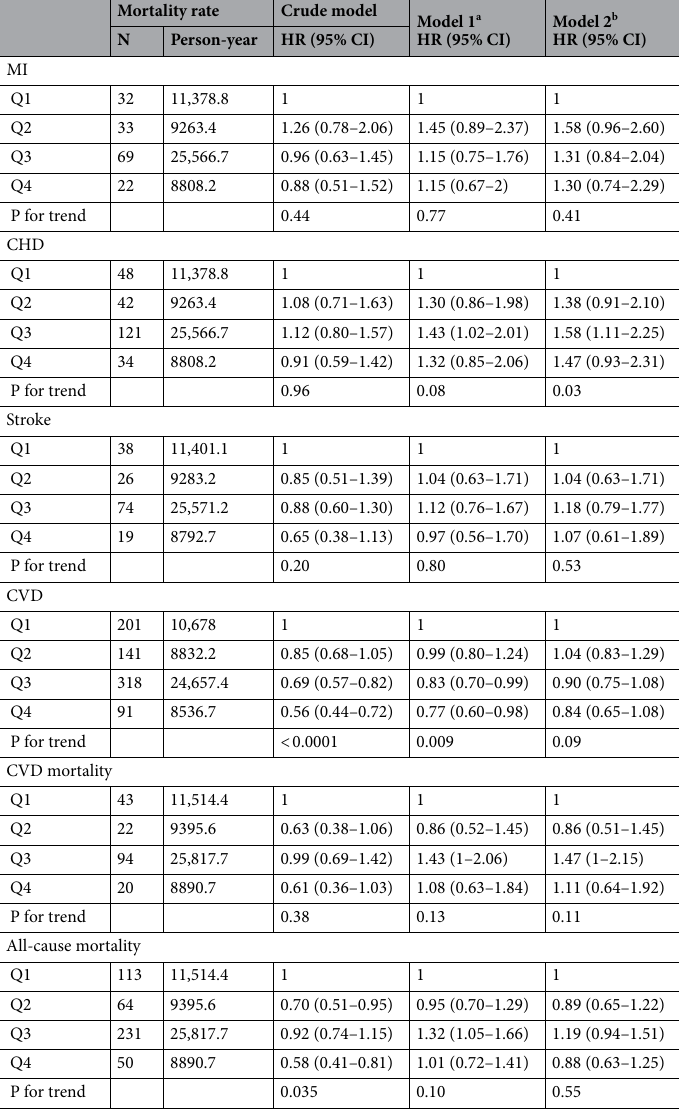
Table 7. Multiple adjusted relative risk of cardiovascular diseases by global dietary index quartiles. a Adjusted for age (year) and sex (men/women). b Additionally adjusted for education (illiterate/primary school/more than primary school), residency (urban/rural), smoking status (never/past/current smoker), daily physical activity (METs-min/day), aspirin use (yes/no), post menopause in women (yes/no), body mass index (kg/m 2 ), hypertension (yes/no) and diabetes mellitus